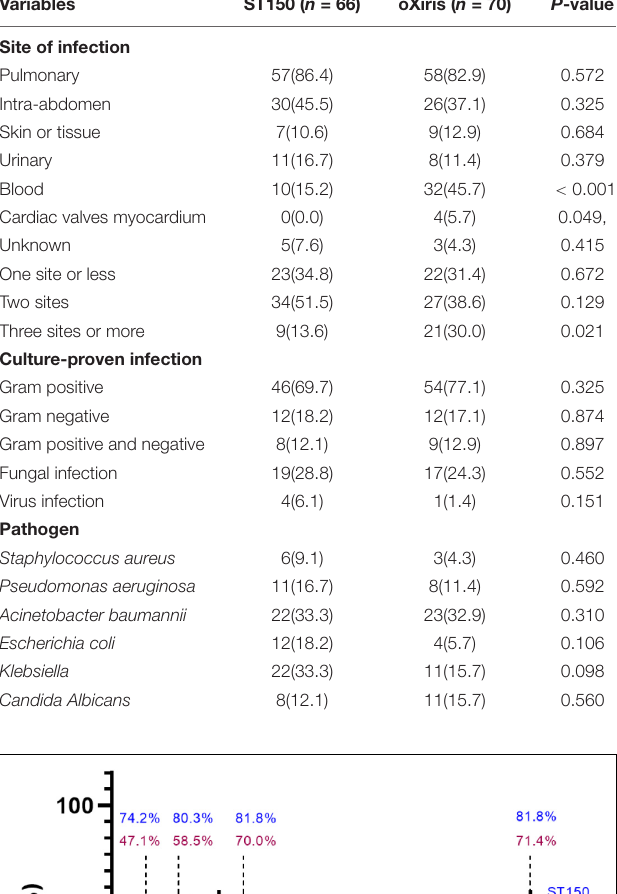
TABLE 3 | The conditions of the infection.